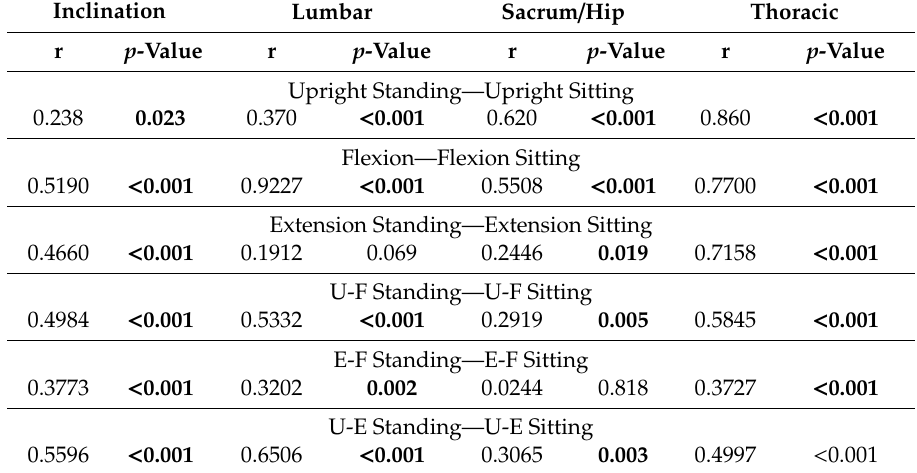
Table 3. Correlation of individual values (degrees) measured in standing compared to sitting positions in upright (U), flexion (F), extension (E), upright to flexion (U-F), upright to extension (U-E) and extension to flexion (E-F) in relation to total inclination, lumbar-, thoracic- and sacrum / hip inclination. Inclination Lumbar Sacrum / Hip Thoracic r p -Value r p -Value r p -Value r p -Value Upright Standing—Upright Sitting 0.238 0.023 0.370 < 0.001 0.620 < 0.001 0.860 < 0.001 Flexion—Flexion Sitting 0.5190 < 0.001 0.9227 < 0.001 0.5508 < 0.001 0.7700 < 0.001 Extension Standing—Extension Sitting 0.4660 < 0.001 0.1912 0.069 0.2446 0.019 0.7158 < 0.001 U-F Standing—U-F Sitting 0.4984 < 0.001 0.5332 < 0.001 0.2919 0.005 0.5845 < 0.001 E-F Standing—E-F Sitting 0.3773 < 0.001 0.3202 0.002 0.0244 0.818 0.3727 < 0.001 U-E Standing—U-E Sitting 0.5596 < 0.001 0.6506 < 0.001 0.3065 0.003 0.4997 < 0.001 r = correlationcoe ffi cient; p -value = levelofsignificance( p < 0.05); r = Spearman’srho;